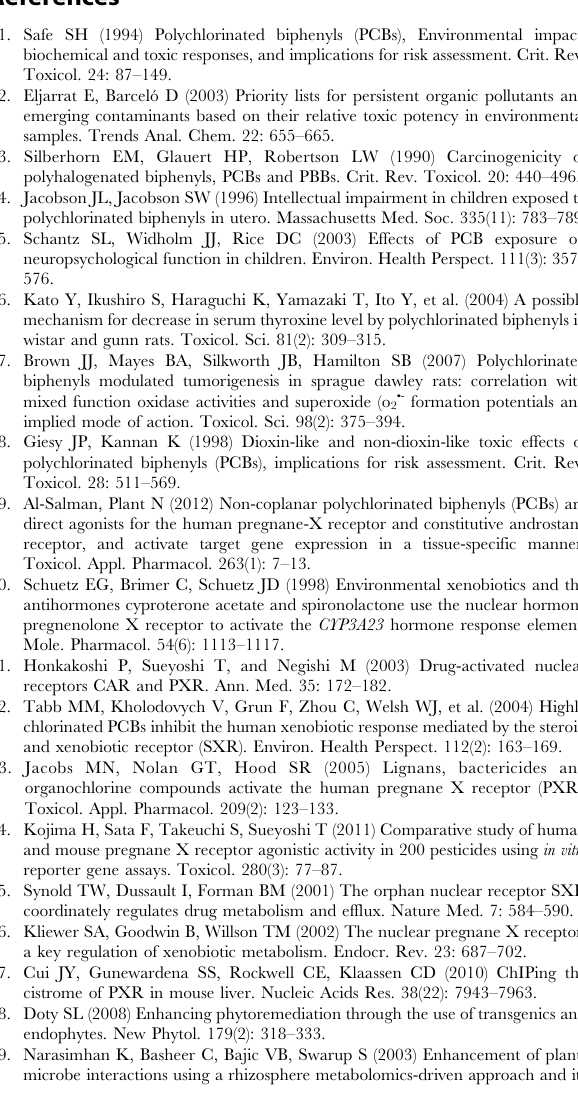
Figure S3 Cotyledons could take up volatile PCBs from the medium. Figure S4 Detailed phenotypical comparison between pcb1 and wild-type. Table S1 PCR primer sequences used in this